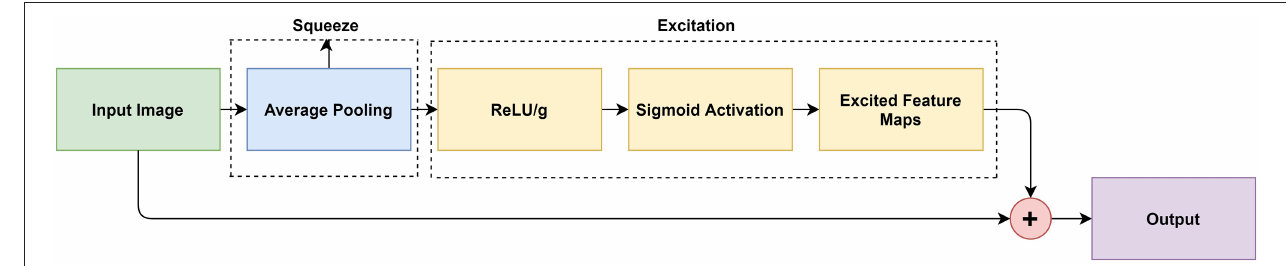
FIGURE 2 | Block diagram representation of the SE module.